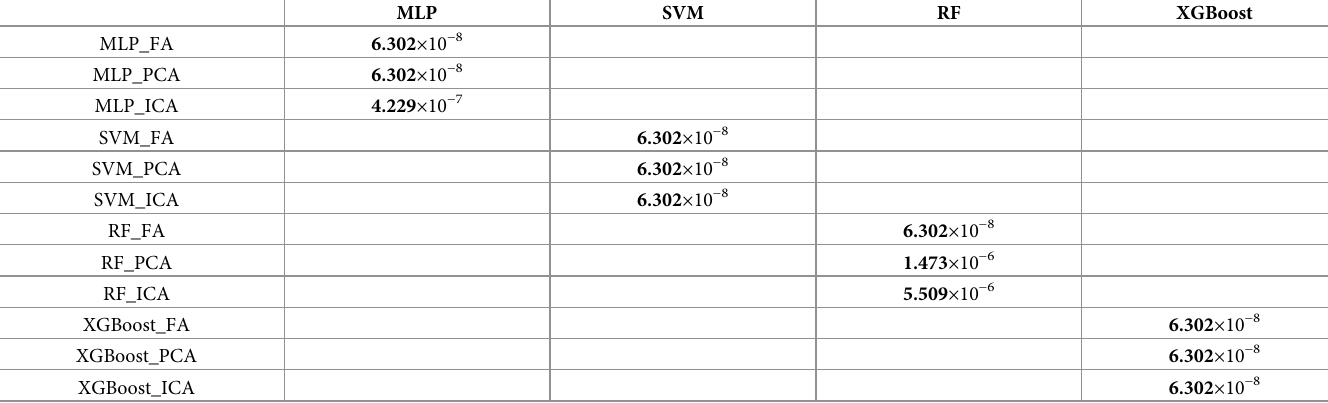
Table 10. Wilcoxon rank-sum tests for the MLP, SVM, RF, XGBoost, and the use of feature extraction, based on the NHANES dataset in terms of RMSE ( p -values less than 0.05 are highlighted in bold).